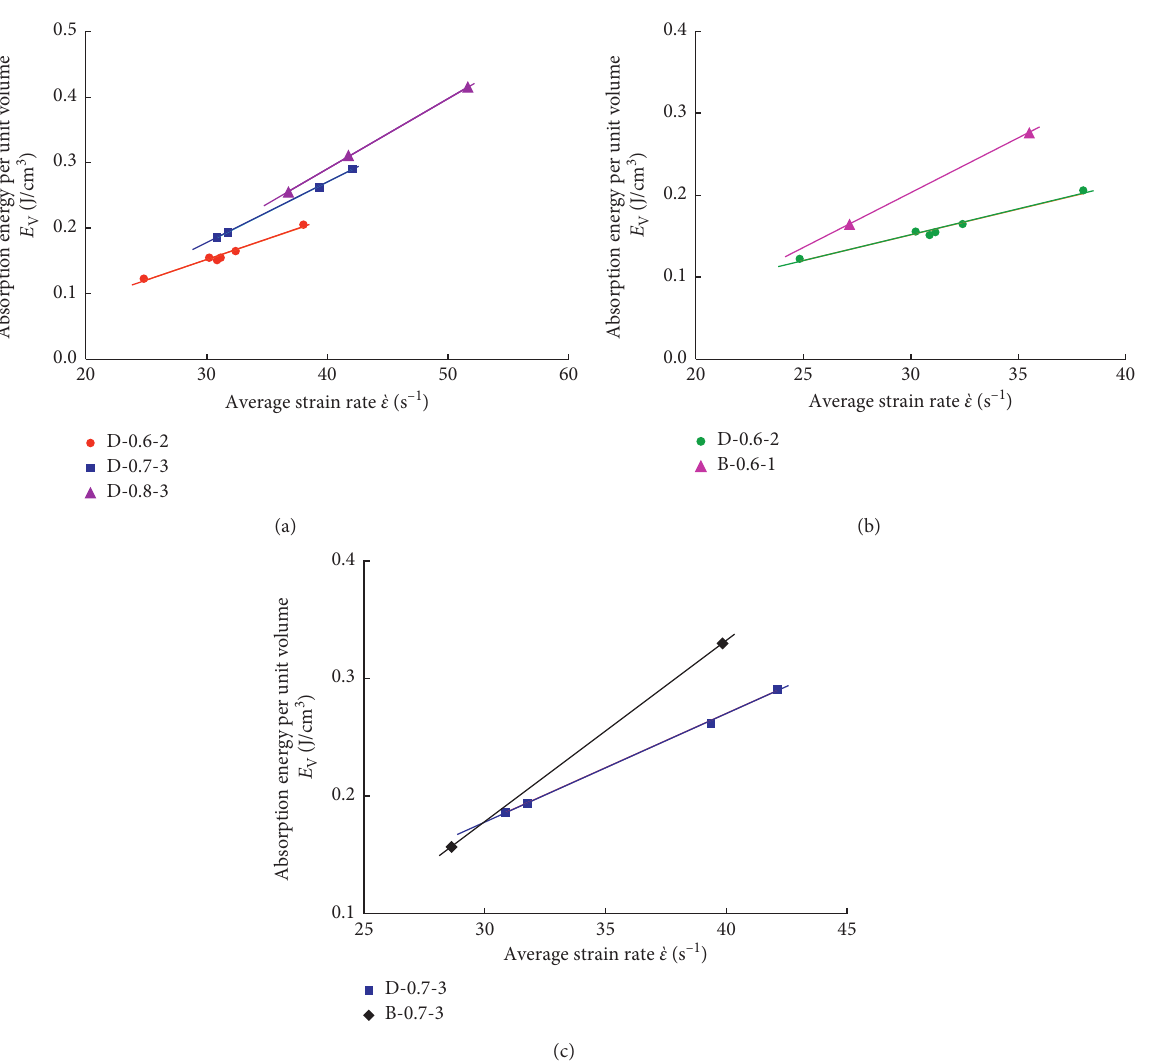
Figure 9: Variation laws of the absorbed energy per unit volume with the strain rate. (a) Pressure shocks of 0.6MPa, 0.7MPa, and 0.8MPa. (b) Pressure shocks of 0.6 MPa and 0.6MPa-0.7MPa. (c) Pressure shocks of 0.7 MPa and